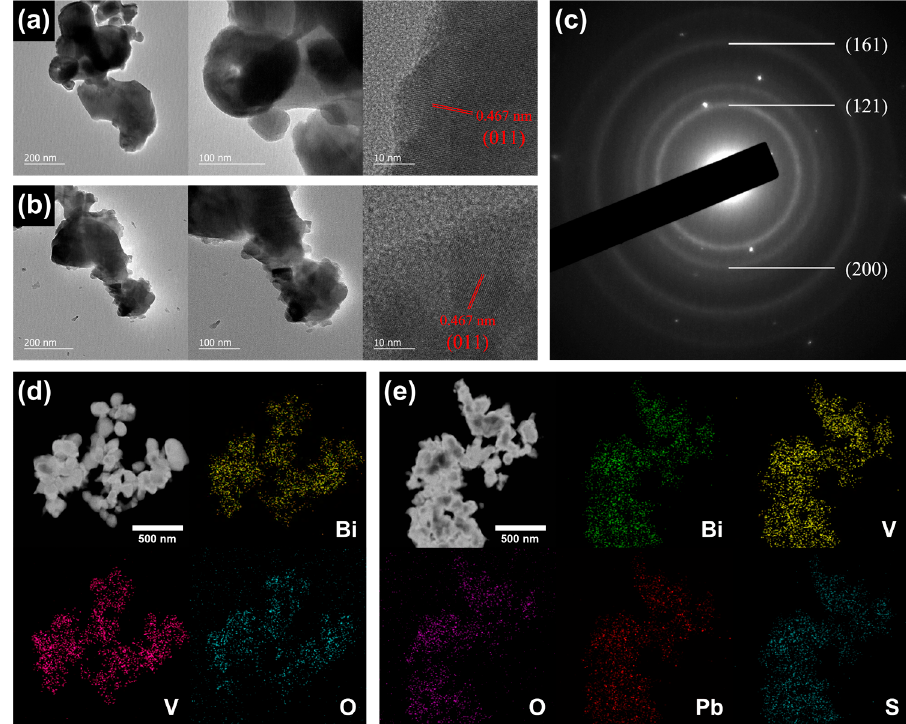
Figure 3. HR-TEM images of ( a ) bare BiVO 4 and ( b ) BiVO 4 /PbS QDs. ( c ) SAED pattern of bare BiVO 4 . EDX mapping for each element (Bi, V, O, Pb, and S) of ( d ) bare BiVO 4 and ( e ) BiVO 4 /PbS QDs.